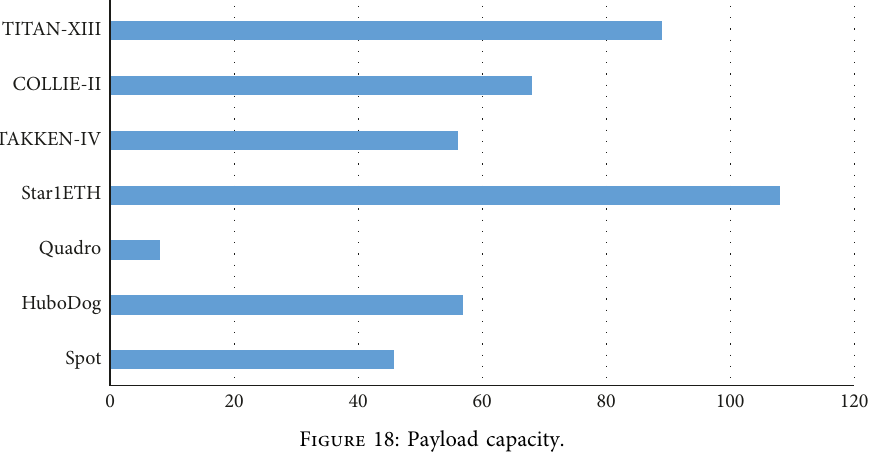
Figure 18: Payload capacity.